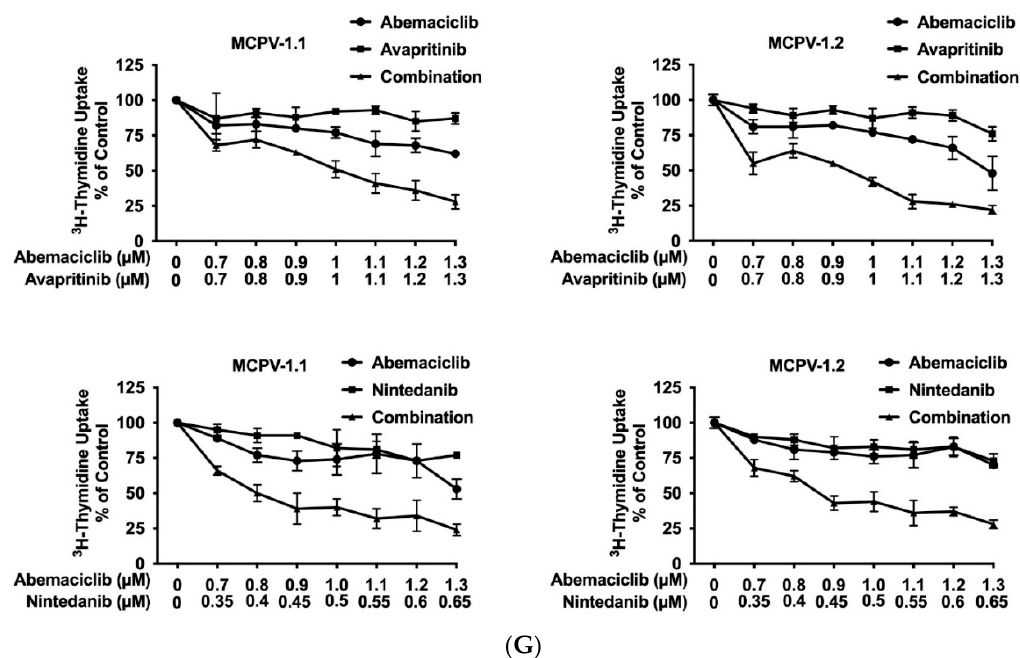
Figure 6. CDK4/CDK6 inhibitors synergize with avapritinib and nintedanib in counteracting proliferation in HMC-1 and ROSA cells. A-C: HMC-1 and ROSA cells were incubated with control medium (0 nM) or medium containing various concentrations of palbociclib ( A ), ribociclib ( B ), or abemaciclib ( C ), alone or in combination with avapritinib, as indicated, at 37 °C for 48 h. ( D – F ) HMC-1 and ROSA cells were incubated with control medium (0 nM) or medium containing various concentrations of palbociclib ( D ), ribociclib ( E ), or abemaciclib ( F ), alone or in combination with nintedanib, as indicated, at 37 °C for 48 h. Thereafter, 3 H-thymidine uptake was measured in a β -counter. ( G ) MCPV-1.1 and MCPV-1.2 cells were incubated with control medium (0 µM) or medium containing various concentrations of abemaciclib alone or in combination with avapritinib (upper panels) or nintedanib (lower panels), as indicated, at 37 °C for 48 h. Thereafter, 3 H-thymidine uptake was measured in a β -counter. Results ( A – G ) are expressed as percentage of control and represent the mean ± S.D from triplicates. Abbreviations: CDK, cyclin-dependent kinase; nM, nanomolar; µM, micromolar.